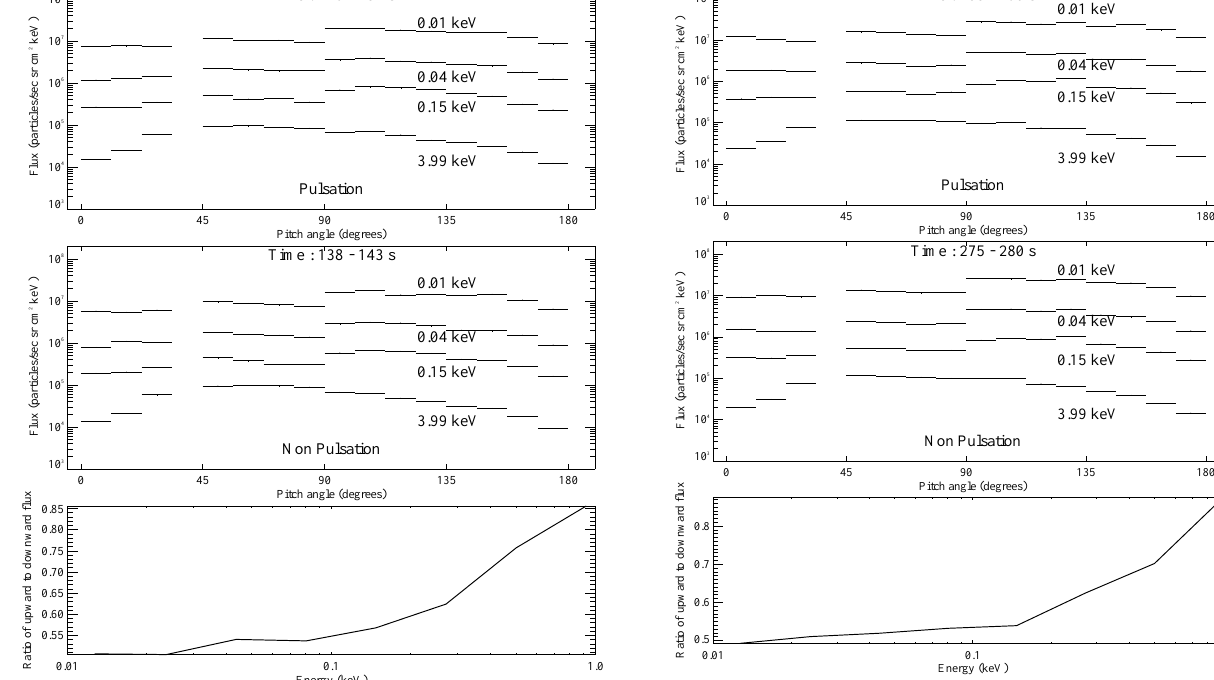
Fig. 9. Pitch angle distributions for selected energies for 146s and 135s. Electrons with energies below 200eV are shown as well as electrons at 4keV. The low energy electrons show a slightly anisotropic distribution. The higher energy electrons begin to show a loss cone at near 50 ◦ pitch angle. The ratio of upward to down- ward pitch angle integrated electrons is shown in the bottom panel.